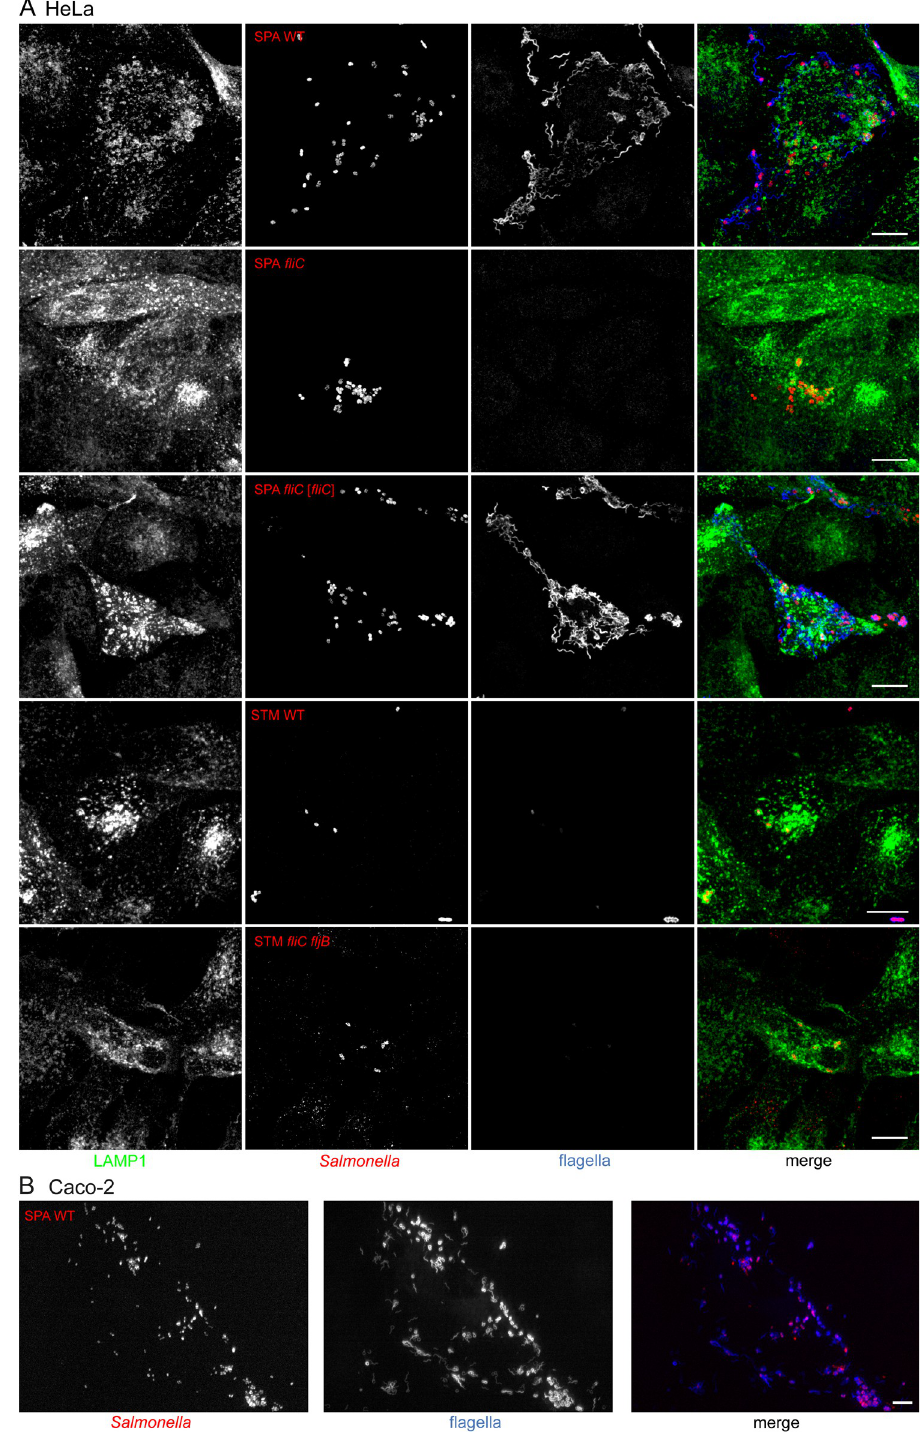
Fig 7. Formation of flagella by SPA within the host cell cytoplasm. ( A ) HeLa cells stably expressing LAMP1-GFP (green) were infected with SPA WT, SPA fliC , SPA fliC [ fliC ], STM WT, or STM fliC fljB as indicated, each constitutively expressing mCherry (red). Infected cells were fixed 8 h p.i. and subsequently immunolabeled with serovar-specific antibody against FliC (blue). ( B ) Caco-2 well were infected with SPA WT constitutively expressing mCherry (red). Cells were fixed 4 h p.i. and immunolabeled for FliC (blue). Scale bars: 10 μ m.